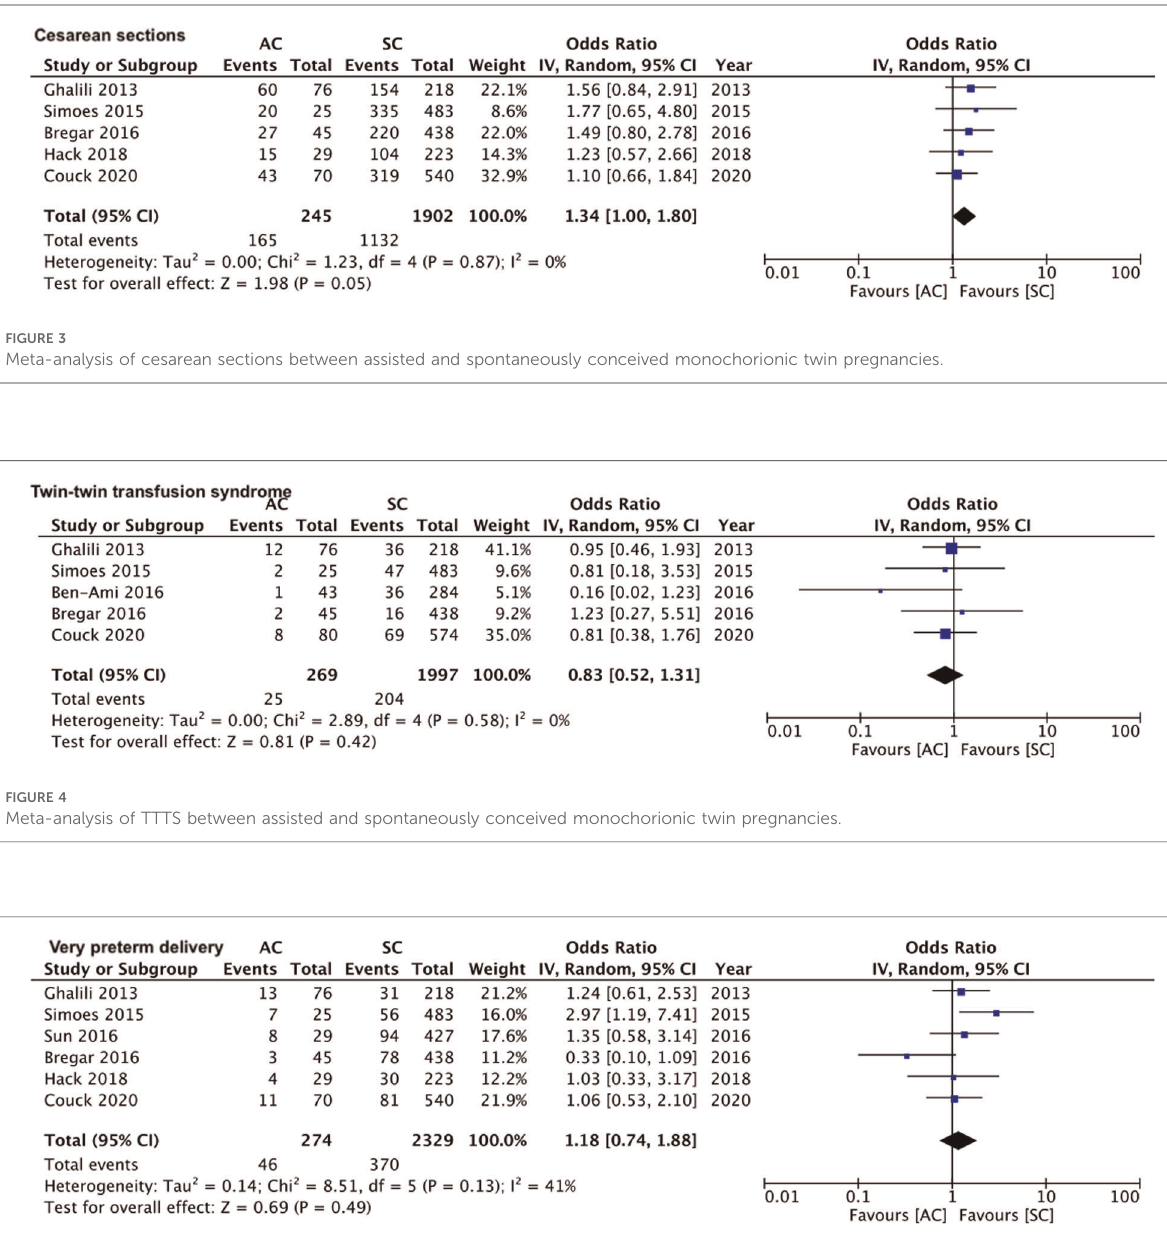
FIGURE 5 Meta-analysis of very preterm delivery between assisted and spontaneously conceived monochorionic twin